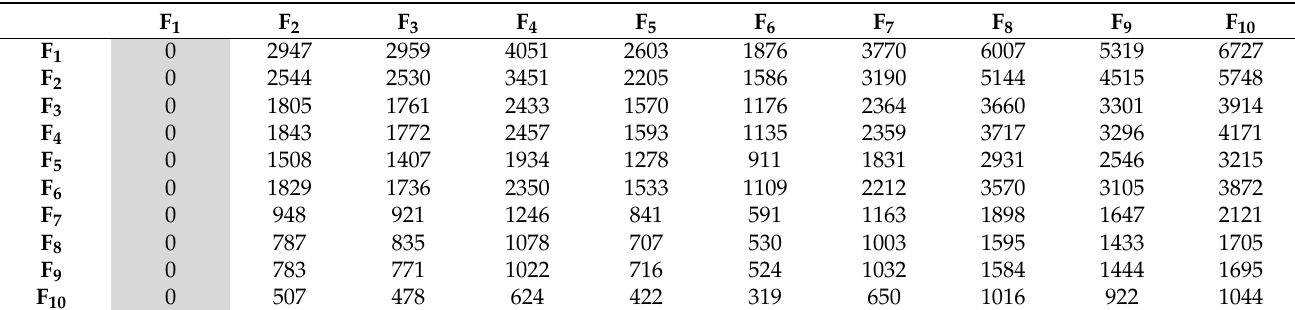
Table 13. The matrix of indirect influence of SCFs.